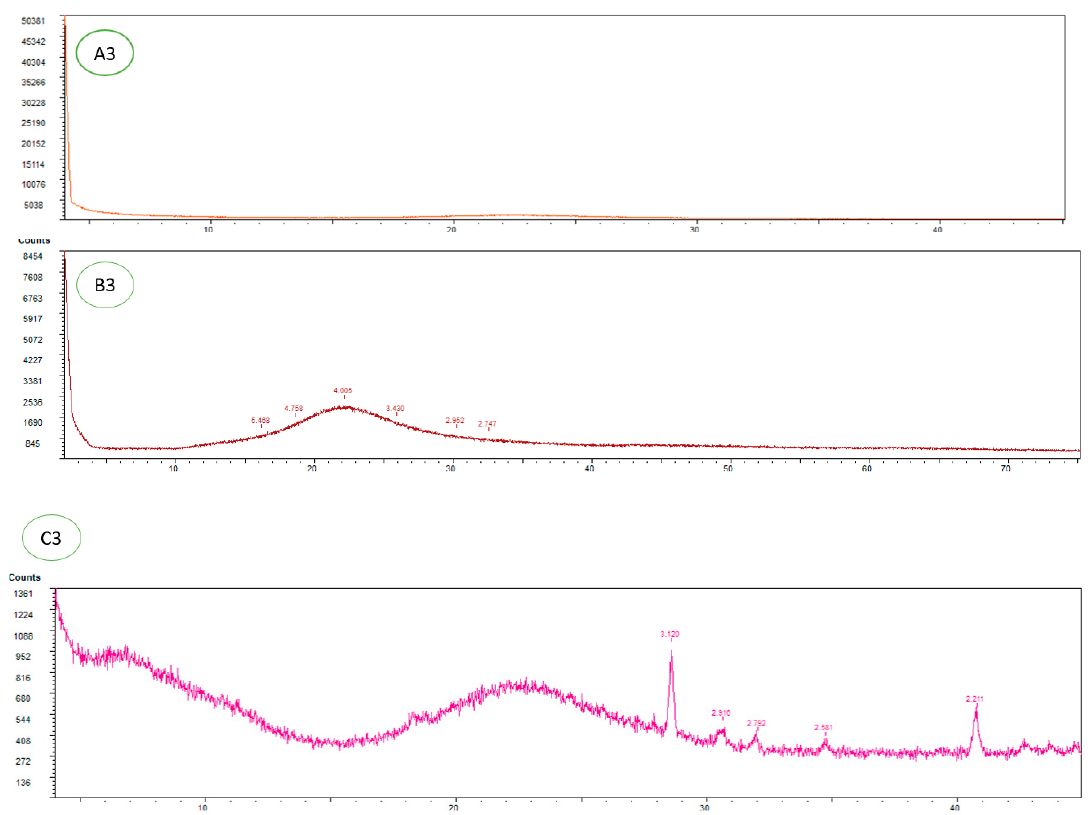
Figure 2. SEM and XRD imaging: A1 – A3 commercial silica. B1 – B3 Silica-supported organocatalyst (S)-5. C1 – C3 Silica-supported organocatalyst ( S )- 5 after 10 catalytic cycles.